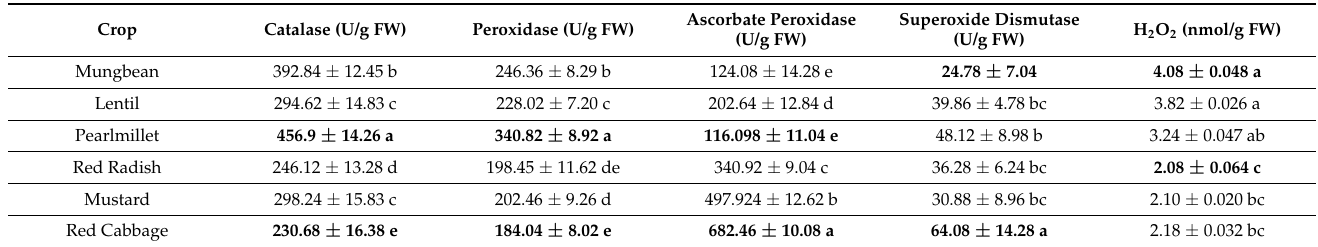
Table 8. Antioxidant enzyme activity and hydrogen peroxide content in